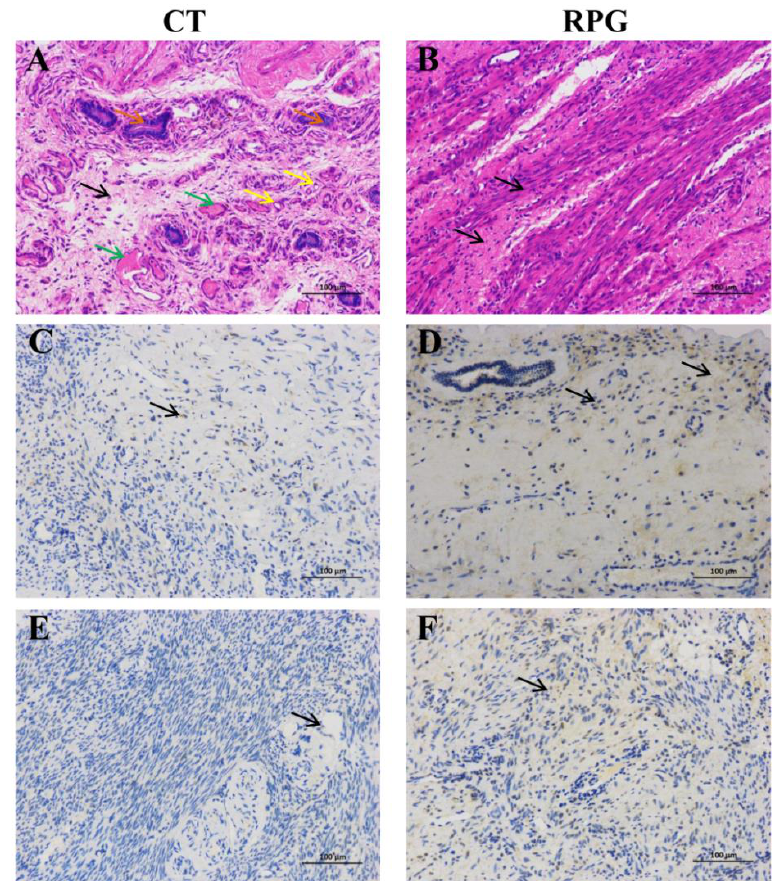
Figure 5. Hematoxylin and eosin (H&E) staining ( A , B ) and immunohistochemical analysis of the expression of IGF1R ( C , D ) and IGF2R ( E , F ) of the endometrium in post-natal dairy cows. In A , large amounts of eosin-stained ( orange arrows ) secretions are found in glandular, and blood vessel congestion and thrombosis ( green ) are widespread, as are the massive neutrophils ( yellow ) in both luminal epithelium and stroma sections. B shows that the shape of cytoplasm and nucleus is uniform in the endometrium. The positive-immunostained immune cells are shown by the arrows in C , D , E and F . Scale bars = 100 μm.